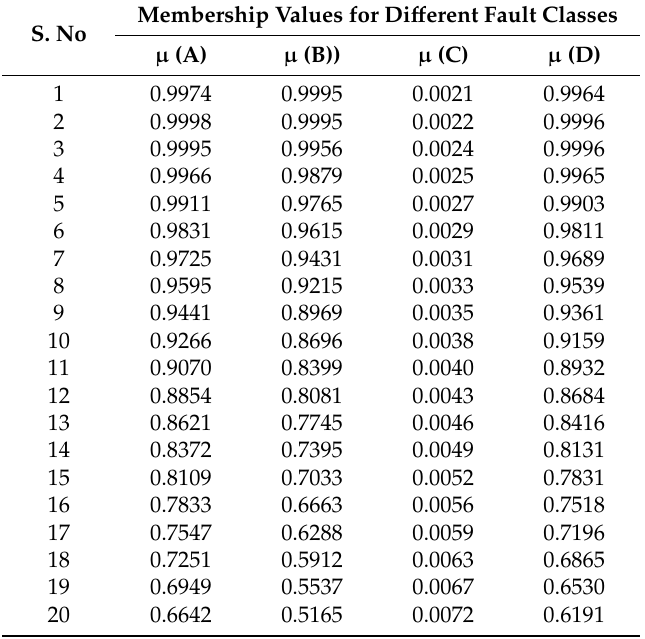
Table 5. Sample membership values of feature data for di ff erent fault ( a ) Estimated membership functions for different bearing faults.